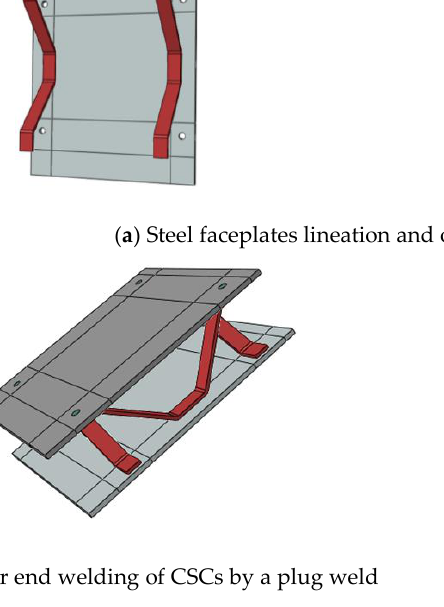
Figure 2. Proposed SCS system interconnected by plug welding of CSCs.